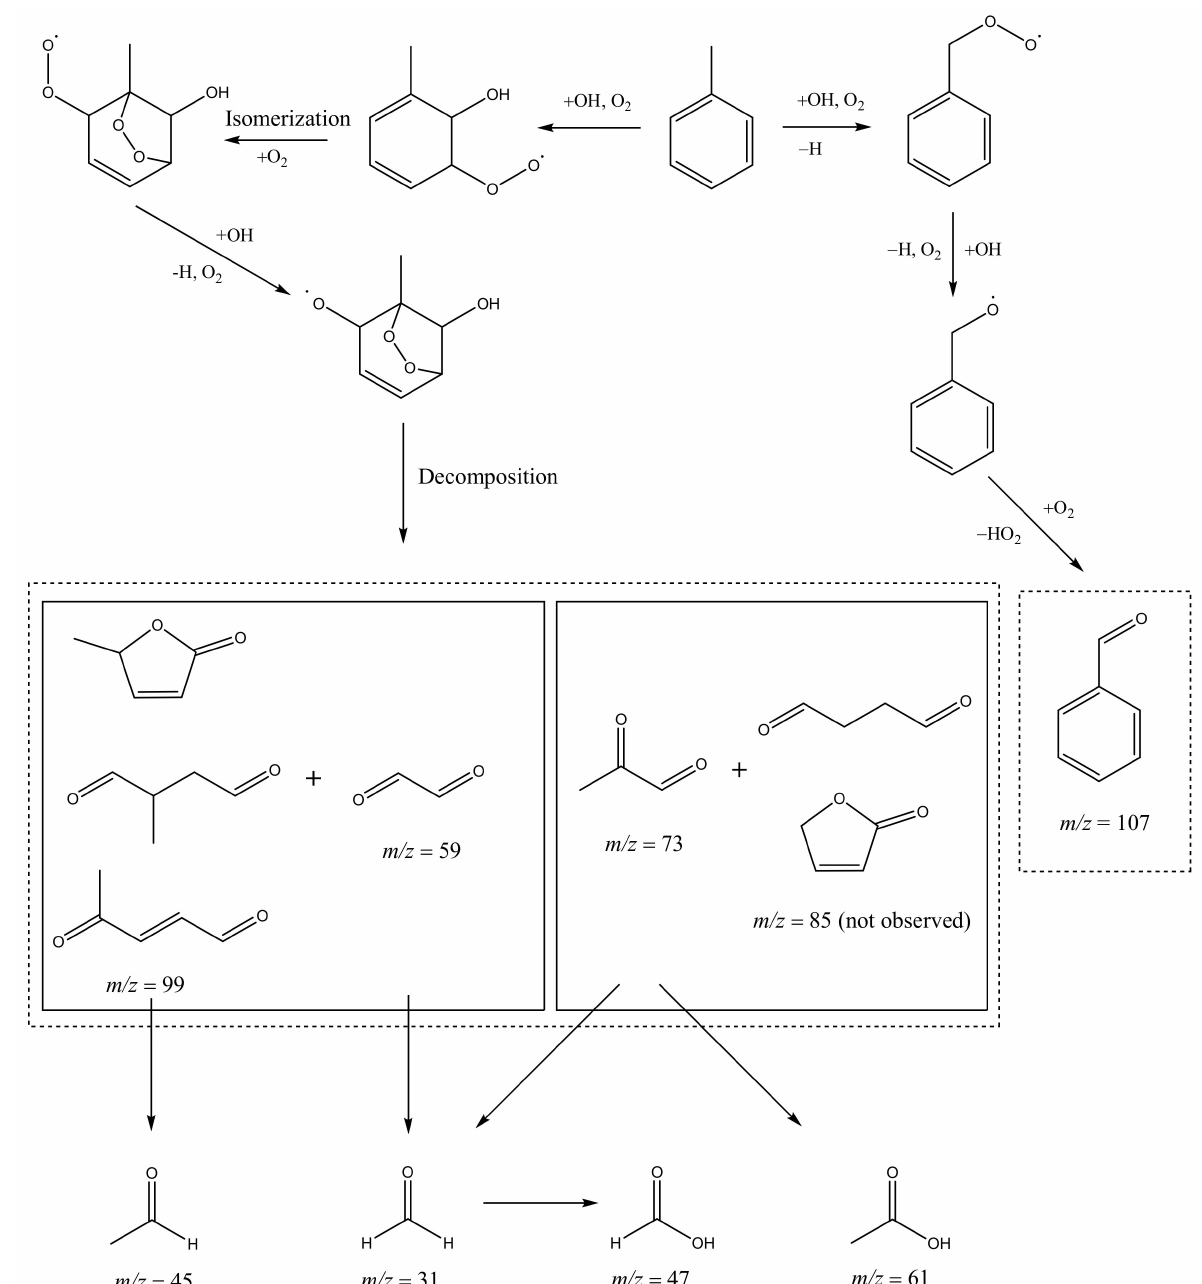
Figure 3. Proposed mechanism of toluene oxidation reaction leading to the products observed in the current